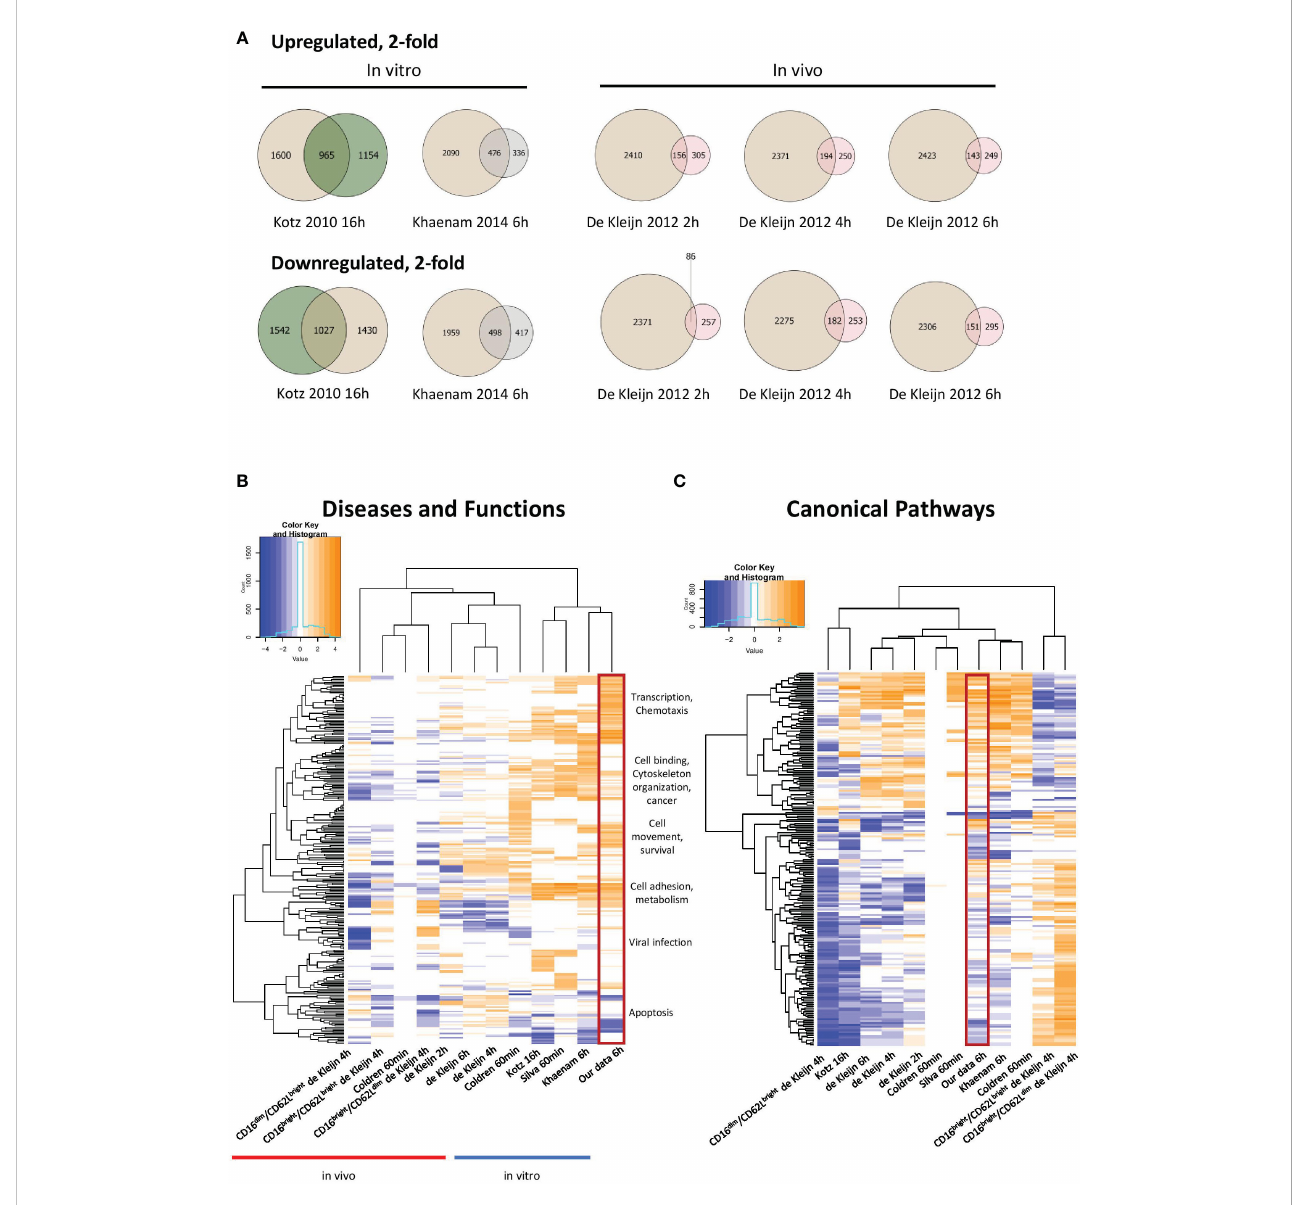
FIGURE 2 Meta-analysis of our data and other previously published LPS-treated neutrophil expression pro fi les. (A) Venn diagrams illustrating partial overlap in genes regulated 2-fold in our dataset and other in vitro and in vivo datasets from LPS-stimulated neutrophils. Tan colour represents our 6h data and green, pink or grey colours represent previously published datasets, as indicated in the fi gure. Enriched diseases and biological functions (B) and canonical pathways (C) of genes in our dataset compared to other datasets from LPS-stimulated neutrophils (-log p value ≤ 1.3). Categories with a predicted activation state (positive Z-score) are labeled in orange while those with a predicted inhibition state (negative Z-score) are indicated in blue. Hierarchical clustering is shown to reveal similarly enriched datasets to our data. Our data is enclosed in the red